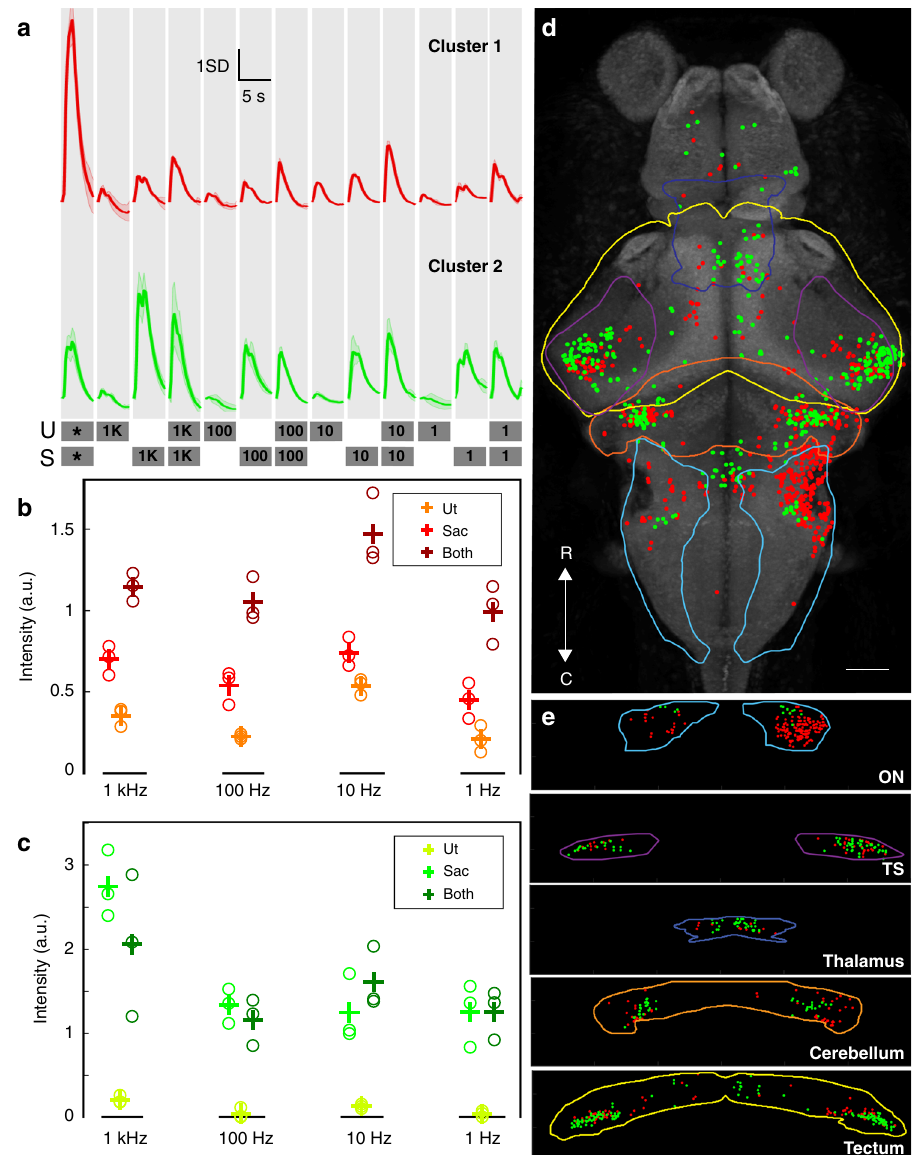
Fig. 3 Auditory and BOA responses across the brain. a The average pro fi les of two 100 Hz tone responsive clusters during acoustic and BOA stimulation. The two bottom lines detail the stimulus train. Gray boxes specify the stimulus windows (1 s of stimulation and 4 s of rest) and the otolith targeted (U, utricle; S, saccule). Numbers on the gray boxes specify the frequency of BOA stimulation in Hz. * represents a 100 Hz auditory tone from a speaker. b , c Intensity of responses of cluster 1 ( b ) and cluster 2 ( c ) to BOA on the utricle (Ut), saccule (Sac), and both at various frequencies. Circles represent peak responses in individual trials (three in total for each OT con fi guration), with mean values shown by “ + ” . d Locations of ROIs belonging to two functional clusters of auditory neurons, viewed dorsally (red for cluster 1 and green for cluster 2). Brain regions of interest are outlined with colored lines, with light blue for octavolateralis nucleus (ON), purple for torus semicircularis (TS), dark blue for thalamus, orange for cerebellum, and yellow for tectum. Data are from six fi sh. Scale bars, 50 μ m. R, rostral; C, caudal. e Distributions of each cluster in the brain regions outlined in d , rotated to produce a coronal